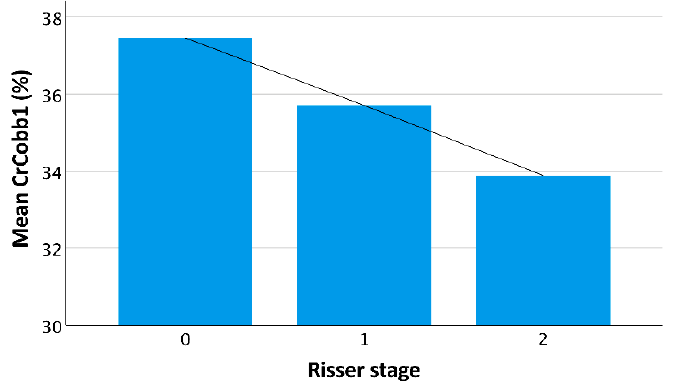
Figure 5. The diagram illustrates the mean Cobb angle correction rate by the braces in relation to patients’ Risser stage. The line illustrates the decrease in mean correction with increasing skeletal maturity ( p = 0.858).